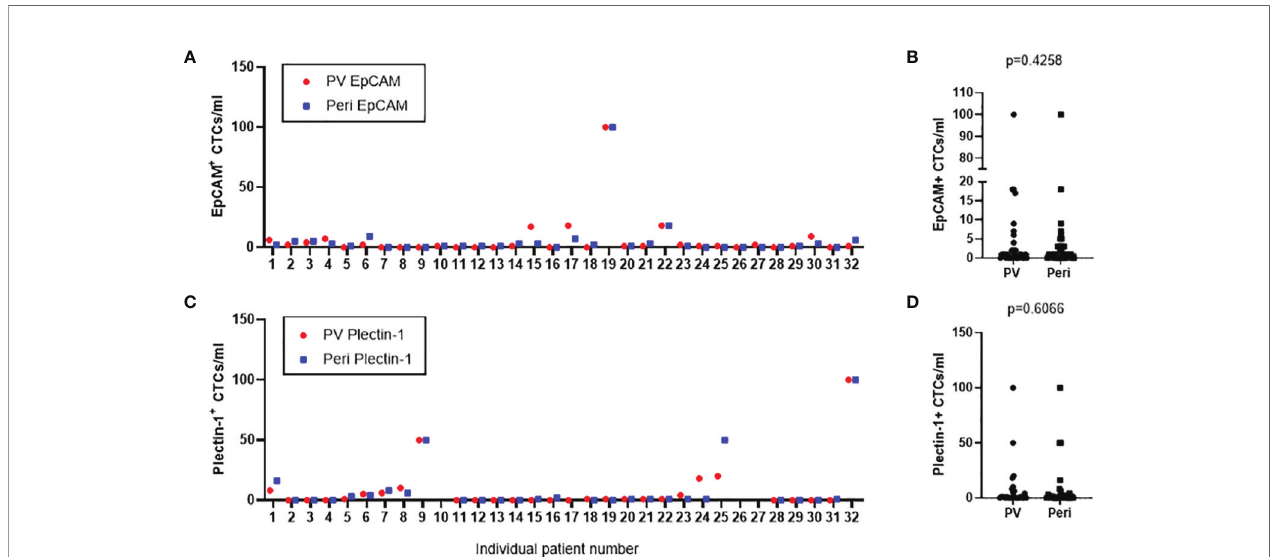
FIGURE 5 | Number of circulating tumor cells (CTCs) detected from the study patients in both portal vein and peripheral blood draws. CTCs were isolated from portal vein (PV) and peripheral vein (Peri) of 32 PDAC patients. (A) EpCAM + CTCs in PV and Peri blood were enumerated from each patient. (C) Plectin-1 + CTCs in PV and Peri blood were counted from each patient. (B) CTCs positive to epithelial cell adhesion molecule (EpCAM) or (D) CTCs positive to Plectin-1 were compared in PV and Peri blood samples.